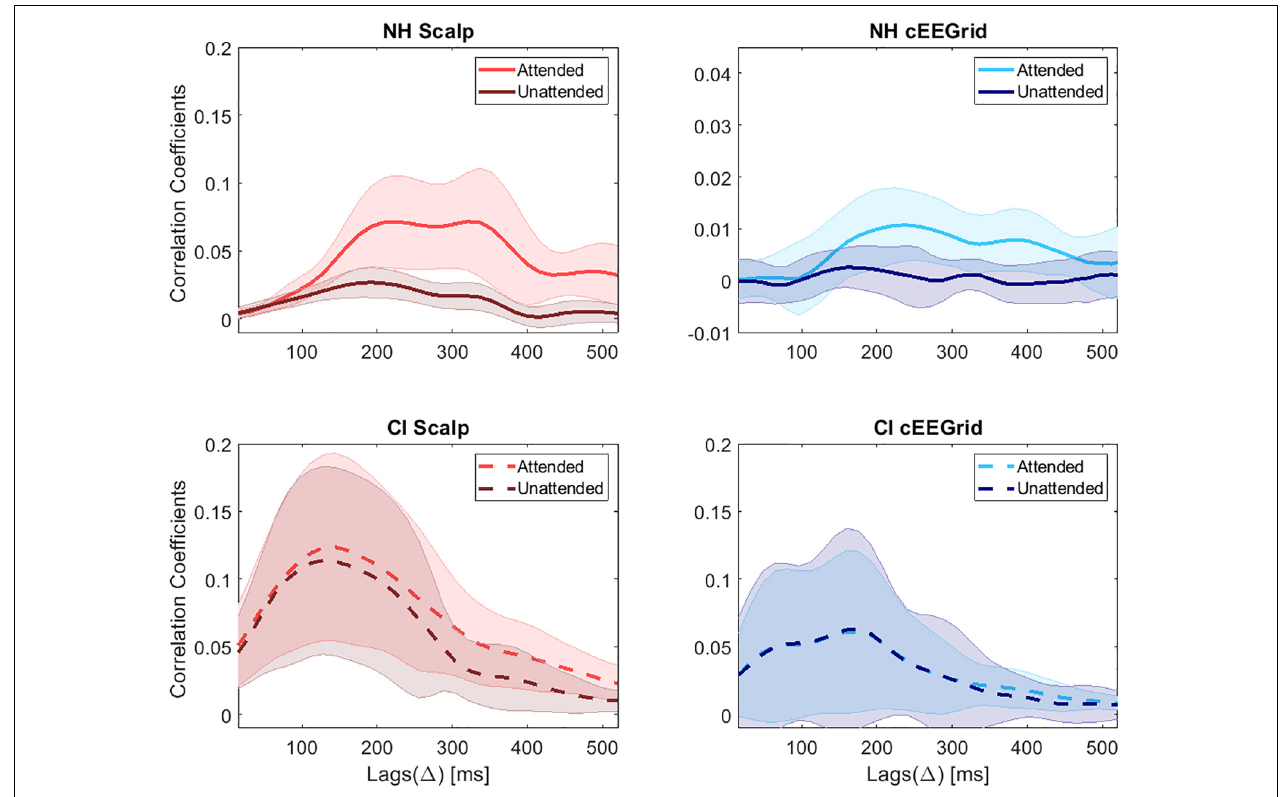
FIGURE 8 | Correlation coefficients for NH listeners and CI users. In each subplot lighter colors refer to the correlation coefficients for the attended speech and darker colors refer to the correlation coefficients for the unattended speech. The thick lines represent the mean values and the shaded areas the standard deviation across